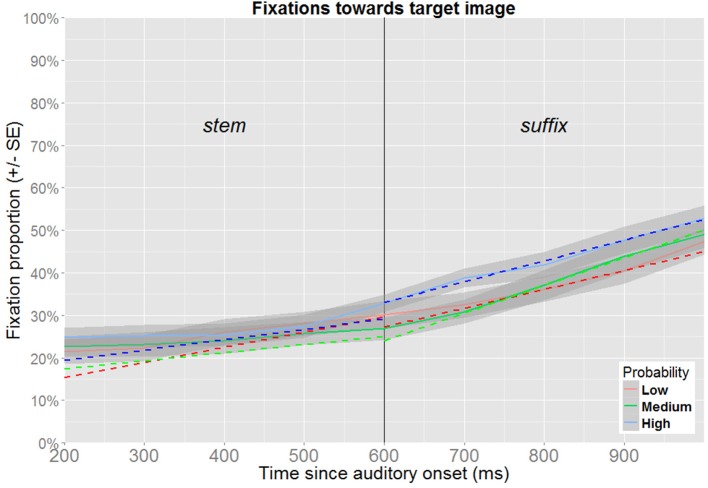
Fixation proportions toward the target according to its probability (target competitor trials). Fixation proportions were aggregated in bins of 100 ms for each participant, and will not correspond directly to model estimates (dotted lines), where random effects are taken into consideration.